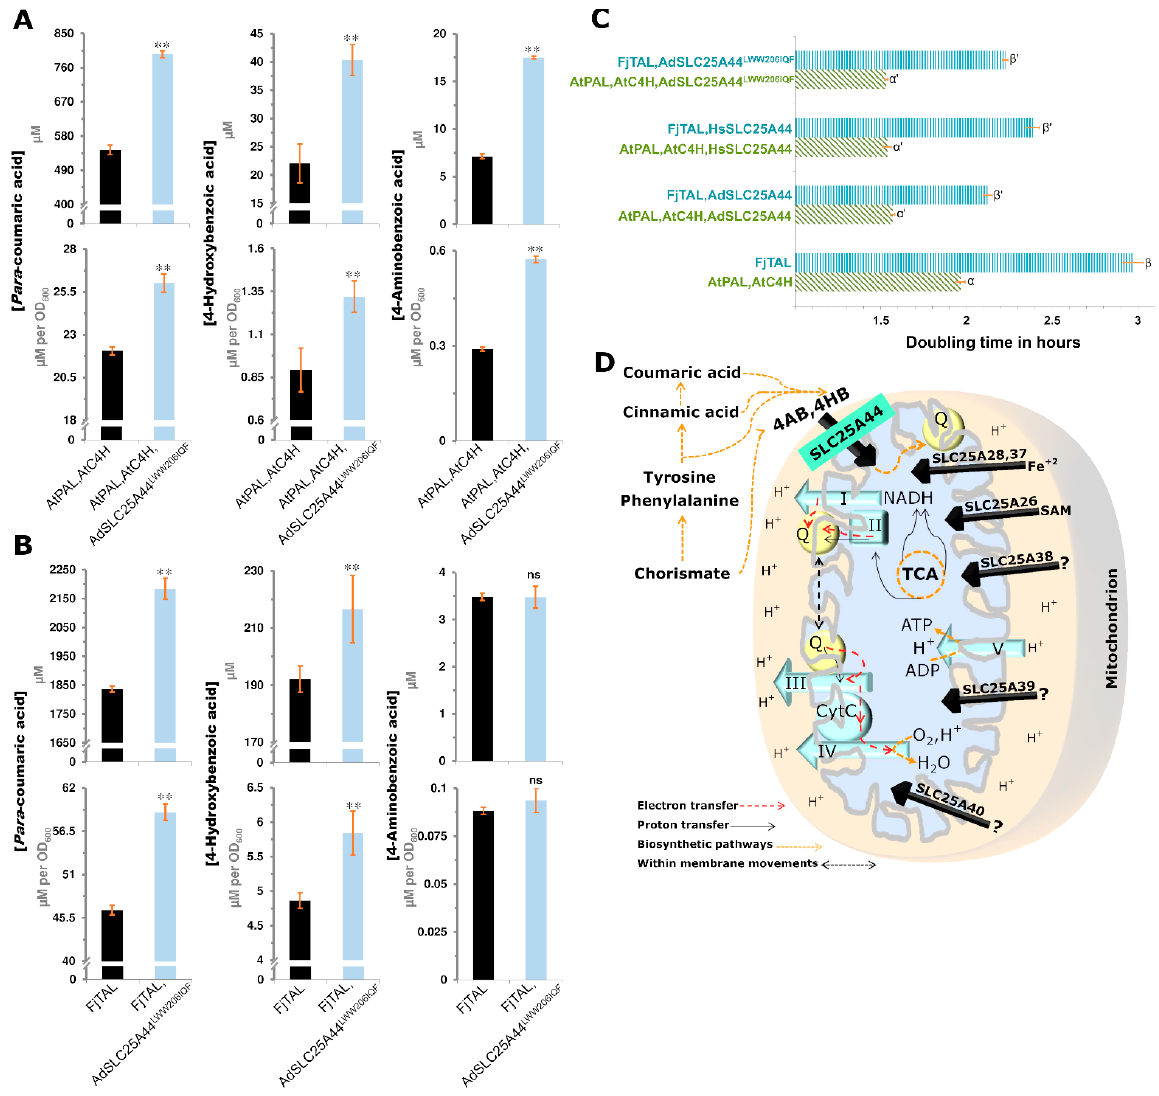
Figure 6. The SLC25A44 is a transporter of ubiquinone precursors with potential to boost the bio-based production of para -coumaric acid. ( A , B ) The effect of Ad SLC25A44 LWW206IQF expression on the production rate of para -coumaric, 4-hydroxybenzoic, and 4-aminobenzoic acids in the PAL and TAL yeast strains. Bars represent mean ±Std. n = 6–9 biological independent samples. The two-tailed Student’s t -test was used to compare the strains with and without Ad SLC25A44 LWW206IQF . The significant events at 1% level are marked by two asterisks. ( C ) Logarithmic cell growth was measured spectrophotometrically at A 600 nm. Significant differences, i.e., α vs . α′ and β vs. β′ ( p = 10 − 4 ), were determined through one-way ANOVA followed by the least significant difference test. Bars represent mean ±Std. n = 3 biological independent samples. ( D ) A simplistic roadmap for the involvement of SLC25A44 and the other transporter members of ETC-clade in the mitochondrial electron transfer chains. 4HB: 4-hydroxybenzoate, 4AB: 4-aminobenzoate, I-IV: electron transfer chains complexes, CytC: cytochrome C, Q: ubiquinone, SAM: S-adenosylmethionine, and ns: not